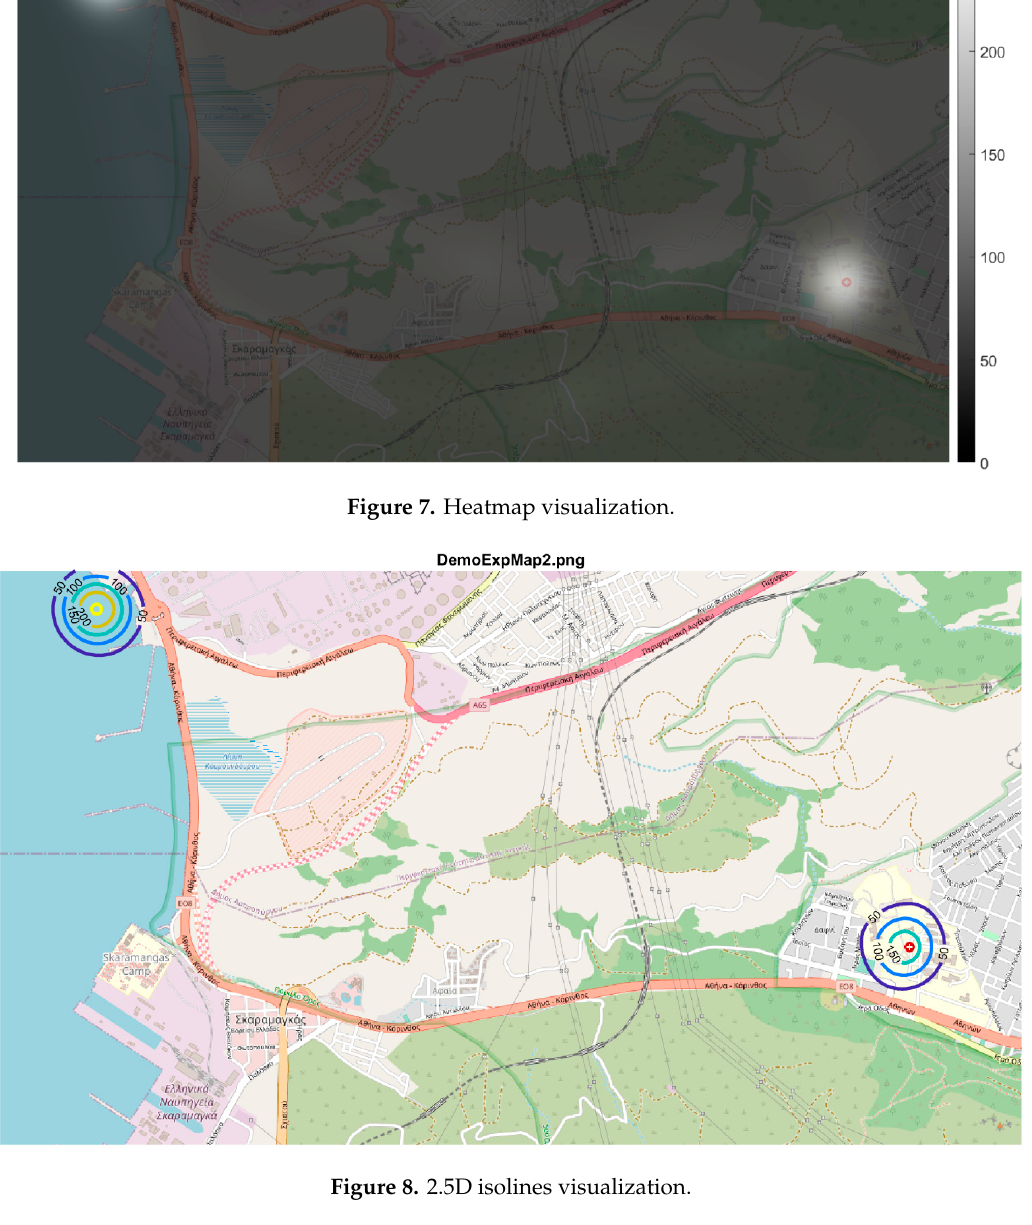
Figure 8. 2.5D isolines visualization.